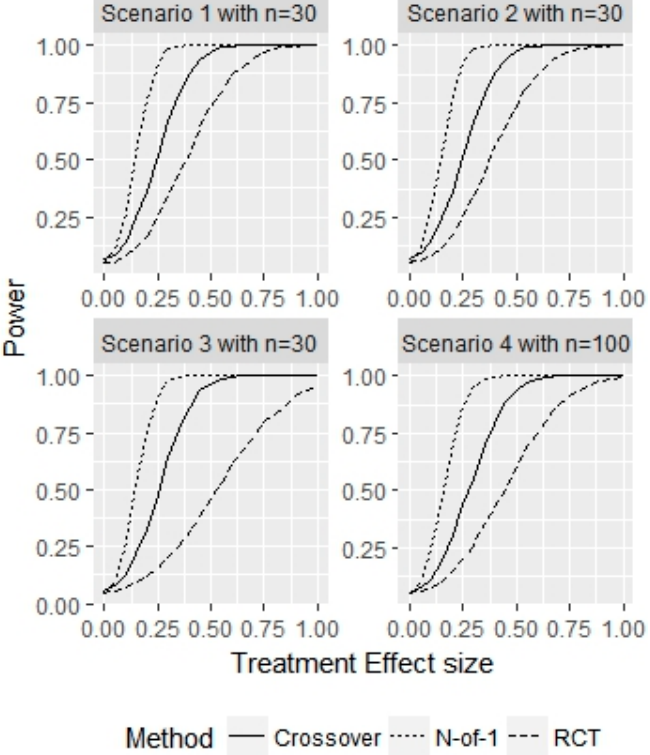
Figure 2. Simulation study for representative sample without washout effects. This figure displays the power for a fixed sample size n with varying true treatment effects τ for the three different designs considered. The power for 𝜏 = 0 represents the type I error